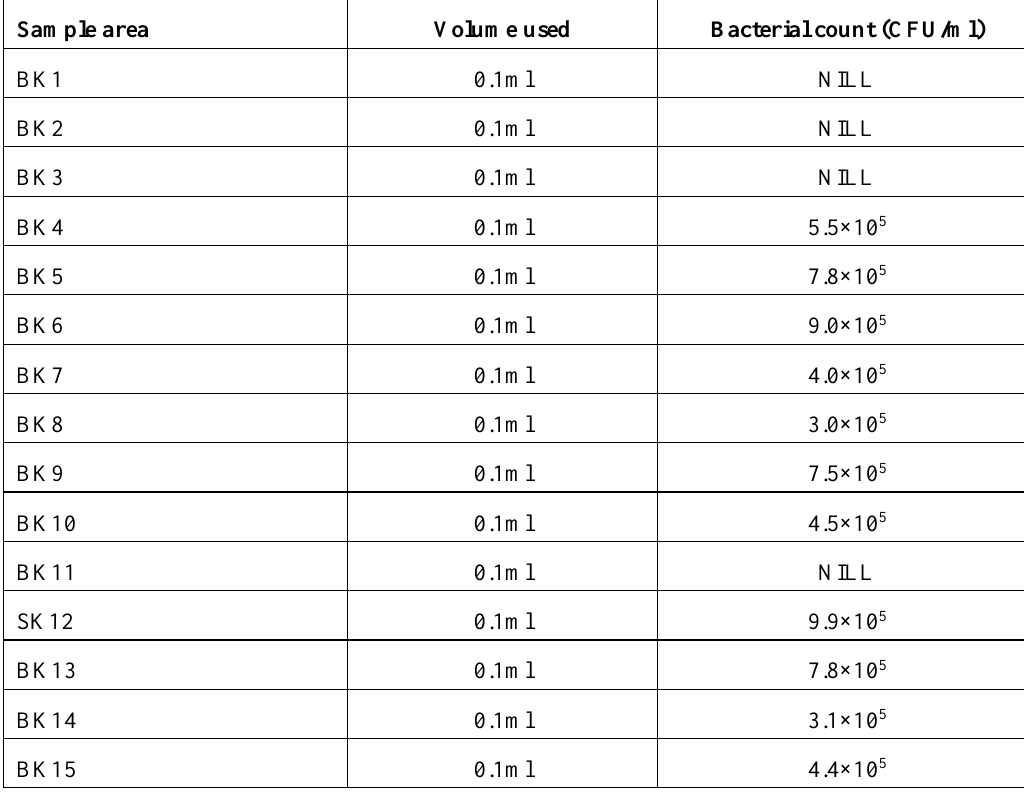
Table 2. Results of total bacterial counts obtained from different packs of disposable plastic cups from main market (babban kasuwa).